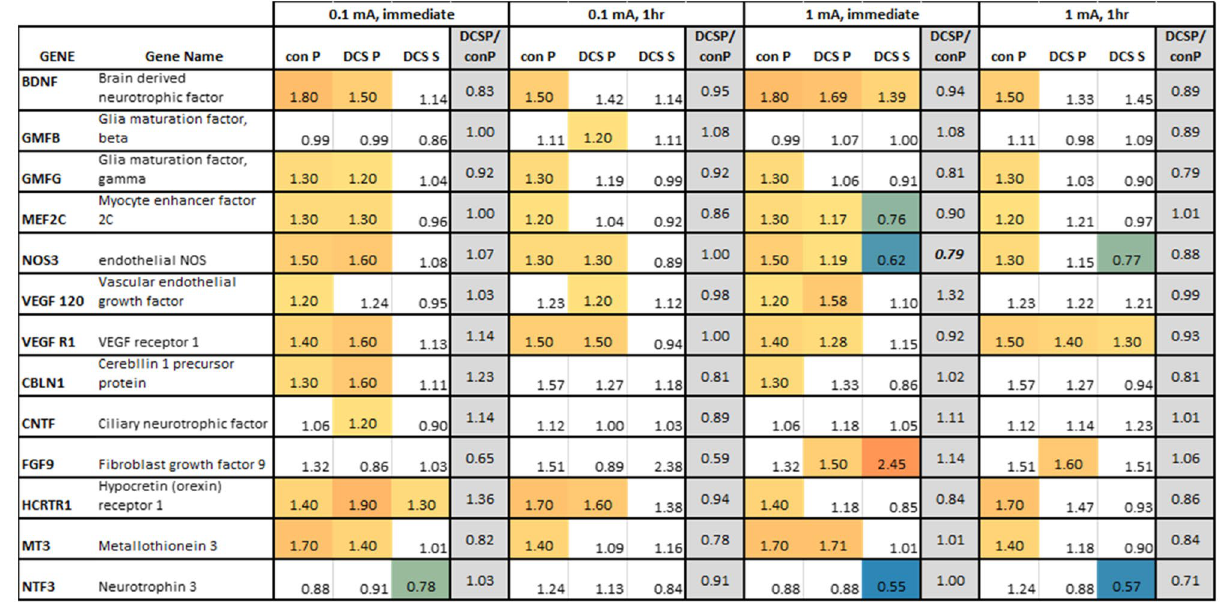
Figure 2. Gene expression for bEnd.3 cells exposed to DCS for 10 min at 0.1 mA or 1 mA with RNA collected immediately or after 1 h. Con P- samples with a hydrostatic pressure gradient that induces convective flow; DCS P- samples with a hydrostatic pressure gradient plus DCS; DCS S-samples under static (no flow) conditions with DCS. Expression shown relative to static control used as calibrator for RT-qPCR. The statistically significant changes are color coded using a 3-color gradient scale where blue to green = downregulation, yellow = onefold, and orange = upregulation, and red = > fivefold upregulation. N > 7 for all cases. Statistical significance determined by Wilcoxon signed rank test with p < 0.05 considered significant. DCS P/con P- shows the fold difference between these samples. Values shown in bold italics denote statistical significance DCS P versus con P by Student’s t test with p < 0.05 considered significant. Full mean + SEM data set shown in supplementary information Fig.